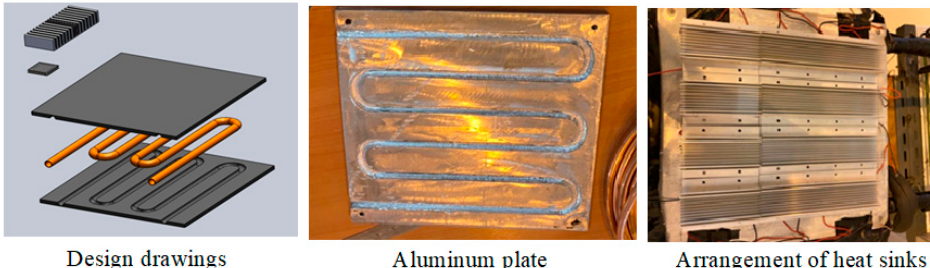
Figure 2. Design and manufacturing details of HE-TEGs unit.